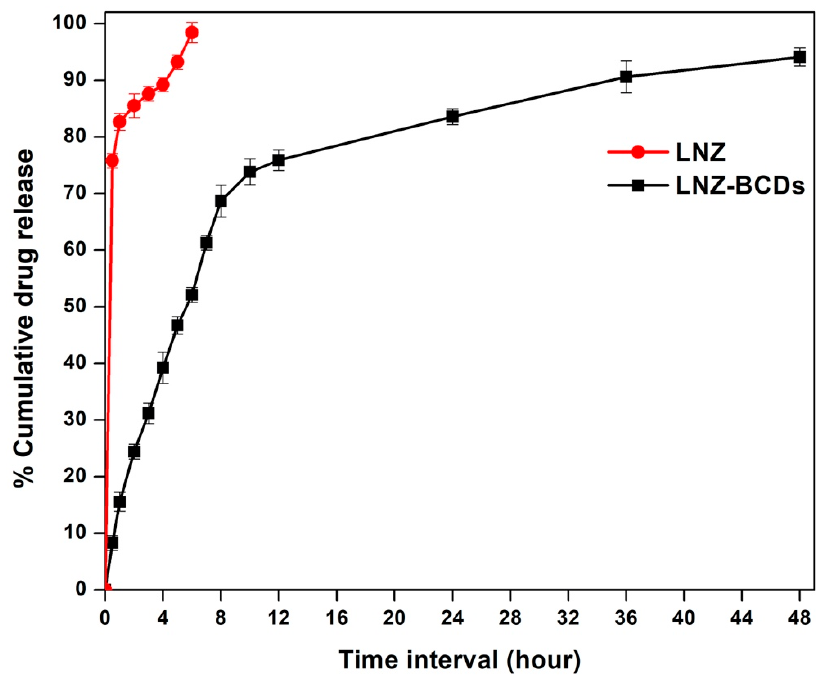
Figure 8. In vitro release profile of the LNZ–BCDs nano-bioconjugate in comparison to the LNZ drug solution in PBS (pH 7.4) at 37 ± 0.2 °C for up to 48 h.